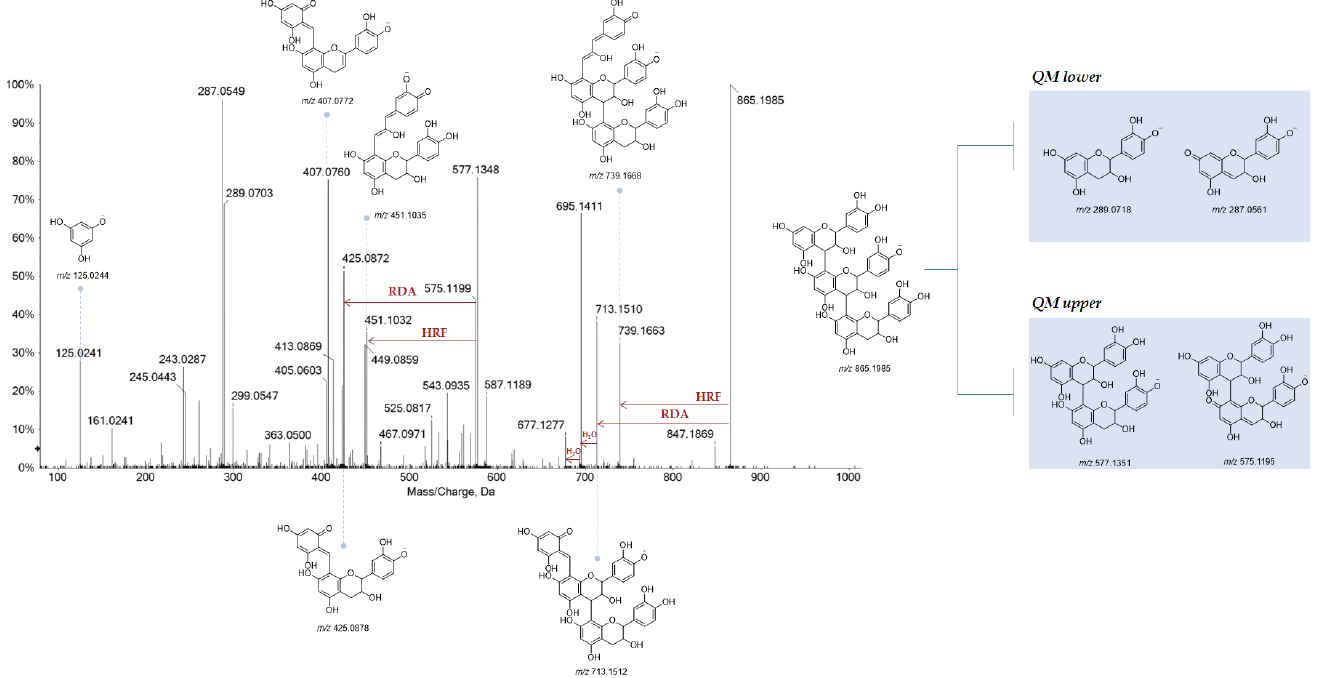
Figure 4. TOF-MS/MS spectrum of compound 19. The chemical structure of each product ion is depicted and its theoretical m / z ratio is indicated below.